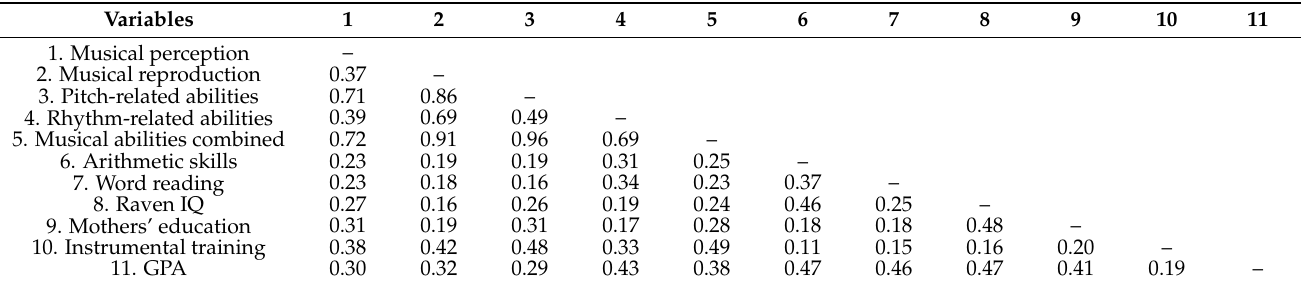
Table 2. Intercorrelations of